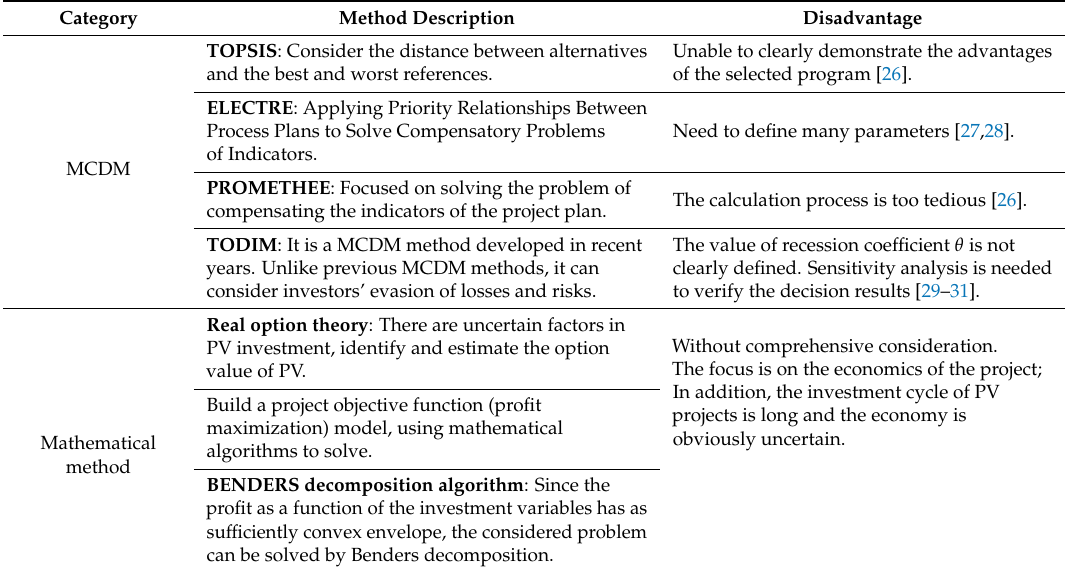
Table 1. Decision methods for RE